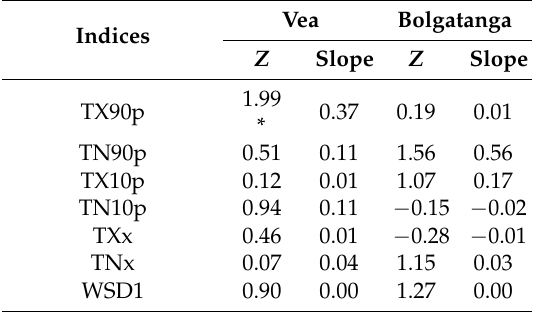
Table 7. MK trend test ( Z ) statistics and Sen’s slope for temperature Indices. Table 7 . MK trend test ( Z ) statistics and Sen’s slope for temperature Indices.